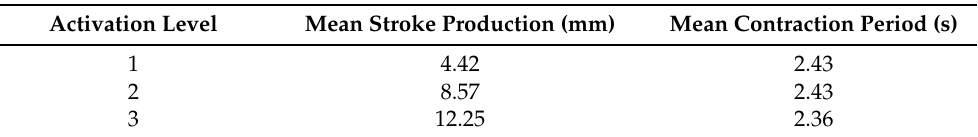
Table 5. Average stroke and contraction period by activation level in the minimum contraction period experiment.